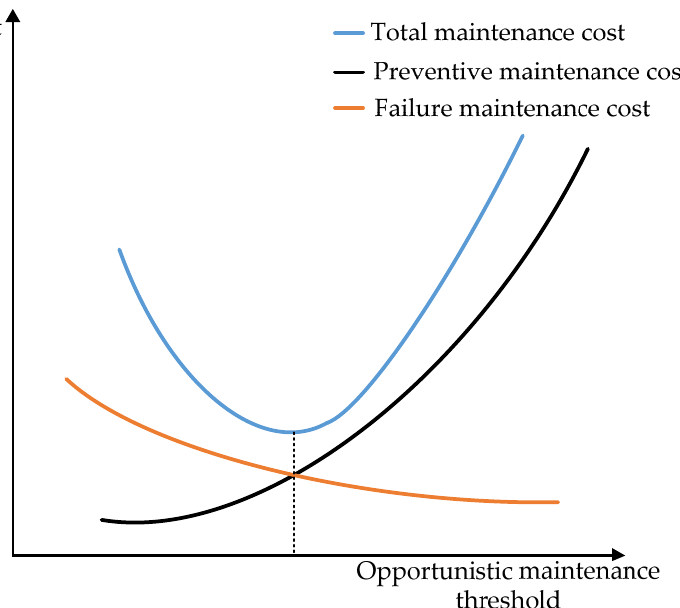
Figure 5. Maintenance cost curve of a multi ‐ component system.